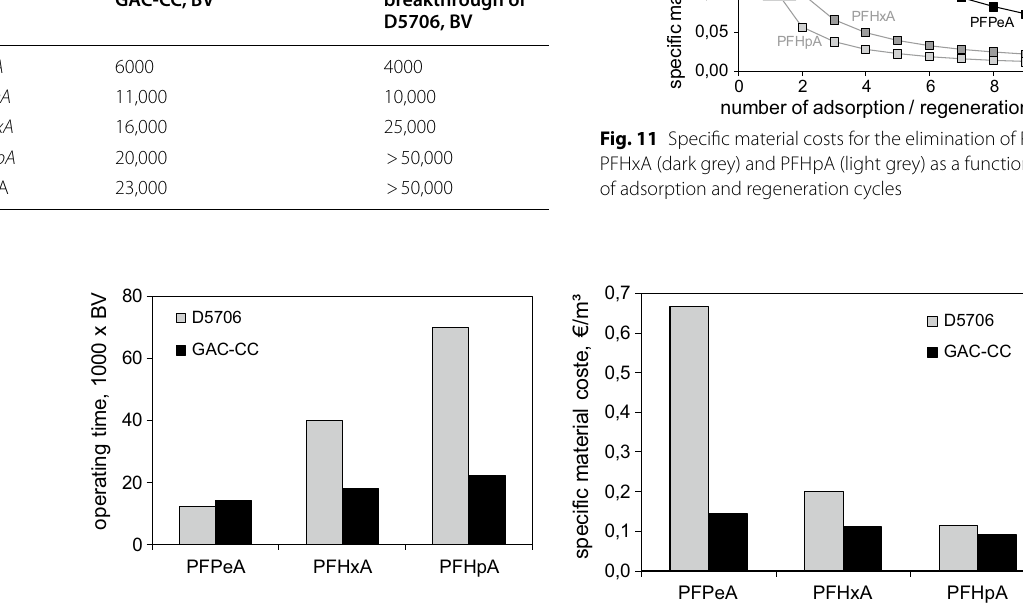
Fig. 10 Operation time and specific material costs per m 3 treated water for one‑time use of adsorbents